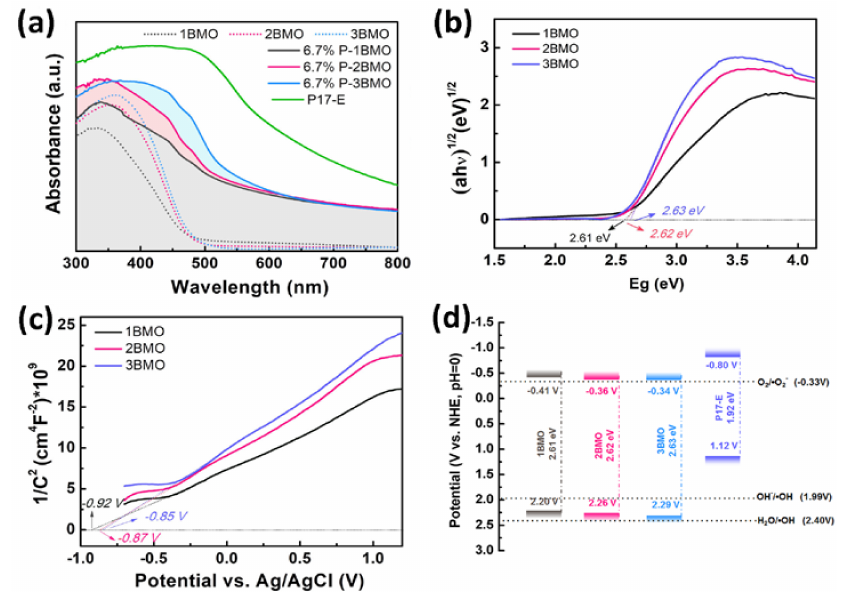
Figure 4. ( a ) Ultraviolet–visible (UV-Vis) absorption spectra of all the samples; ( b ) plots of ( α h ν )1/2 versus energy h ν ; ( c ) Mott–Schottky plots for 1BMO, 2BMO, and 3BMO; and ( d ) the diagram of band positions for 1BMO, 2BMO, 3BMO, and P17-E.